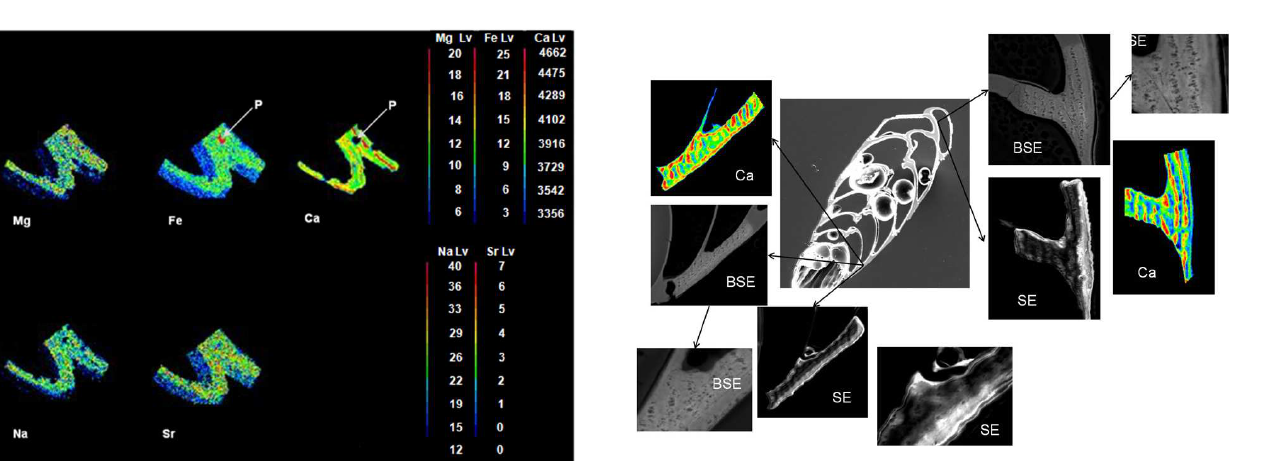
Fig. 7. EMP elemental mapping of a section from a Bolivina spissa from 465m water depth (M77-1-455/MUC-21) on an exposed sec- tion of the foraminiferal test specimen treated with an oxidative cleaning procedure. Distribution of Mg, Fe, Mn, S and Ca in the foraminiferal test. All intensity values are expressed in counts per second (cps) as shown in the color bars. Note that no contaminant phases are visible in the Fe distribution except inside a test pore ( P ).